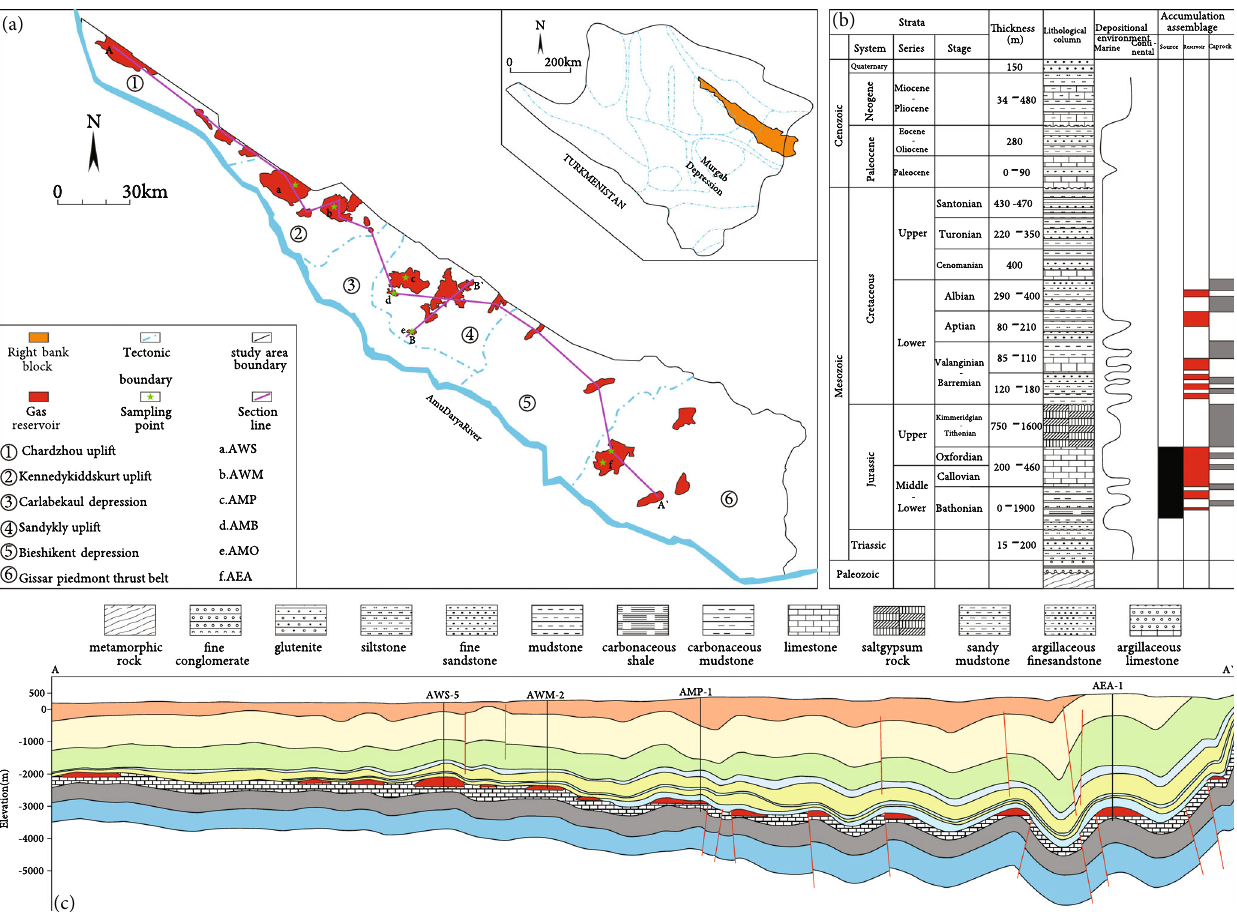
Figure 2: Structural units, the location of sampling points, composite stratigraphic columnar section, and gas reservoir pro fi le in the Amu Darya Right Bank